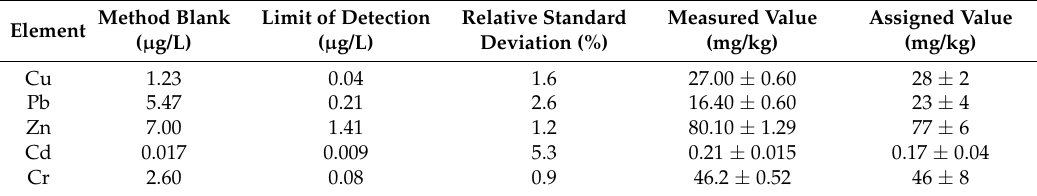
Table 1. Measured and certified values of metal concentrations in standard reference